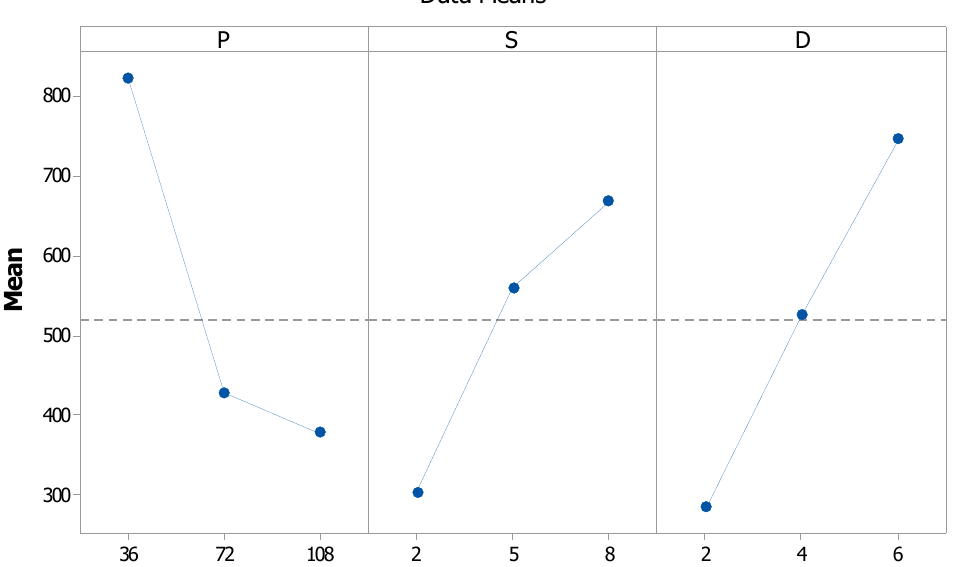
Figure 3. The effects of input parameters on the radius of curvature of laser-formed cylindrical surfaces.